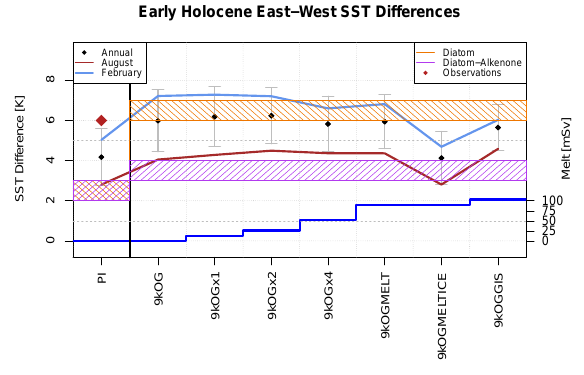
Fig. 4. Simulated east–west SST differences across the Nordic Seas for 9kaBP snapshot simulations and an additional present-day (PI) simulation for comparison. Corresponding eastern model area 47.5– 10 ◦ W, 68.75–81.25 ◦ N and western 2.5–20 ◦ E, 66.25–78.75 ◦ N. Points mark the annual mean difference, grey bars give associated standard deviation, red line gives August value and light-blue line gives February value. Values are calculated from the last 100yr of each experiment. Dark-blue line at the bottom gives the total amount of freshwater added to the simulations inmSv. Orange bar indi- cates diatom-based SST differences. The value shown in purple is constructed from Andersen et al. (2004) by combining the diatom- based SST estimate in the western Nordic Seas and the alkenone- based value (Calvo et al., 2002) in the eastern Nordic Seas. Red square indicates modern day value from Smith et al. (2008) in the period of 1854 to 1950 AD.